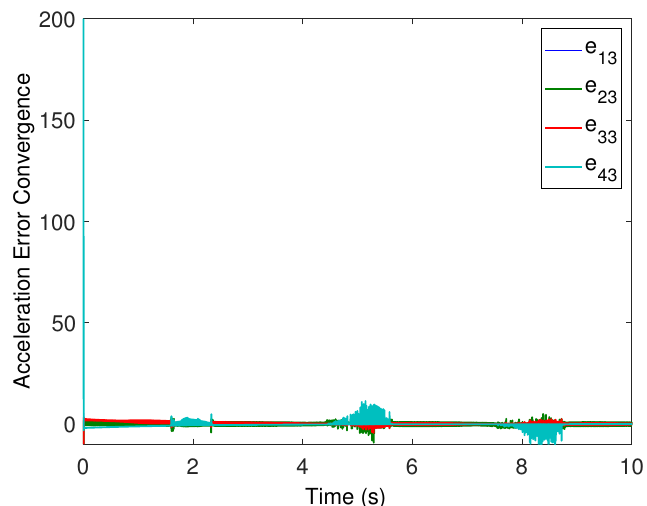
Figure 7. Acceleration errors’